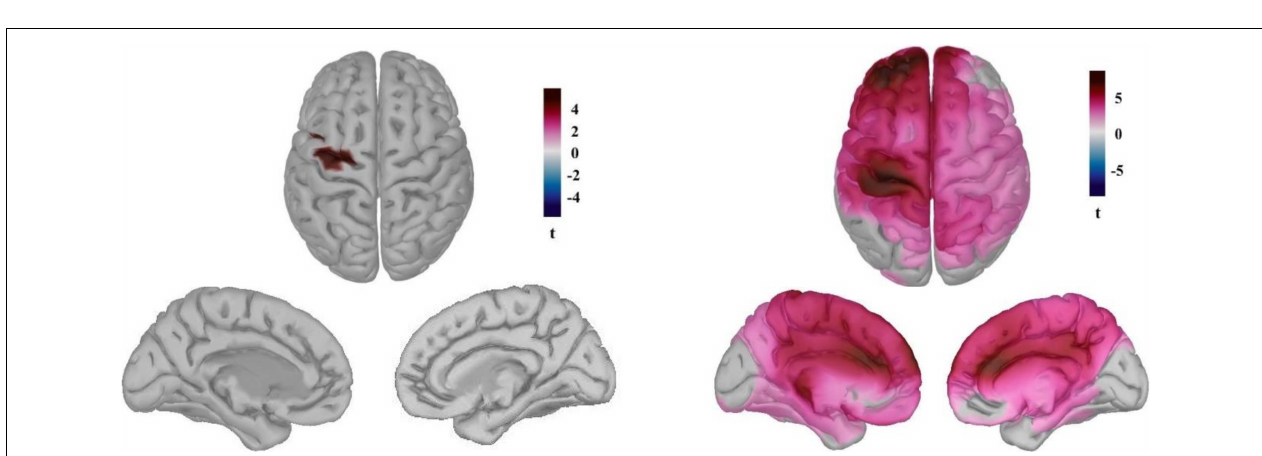
FIGURE 3 | (A) Neural sources of the differential HEP for the pre-game and the game conditions. Different activation patterns were identified in the left primary somatosensory and the left supplementary and primary motor cortices extended to the left posterior cingulate cortex (t pertains to permutation test results considering α < 0.01 with FDR correction) stemming from higher activation during the pre-game condition, (B) Reconstructed time course of the HEP in the left primary somatosensory cortex grand averaged across all subjects in absolute values of dipole currents for the pre-game and the game conditions. The shaded area shows the time window in which significantly more activation was observed during the pre-game condition.